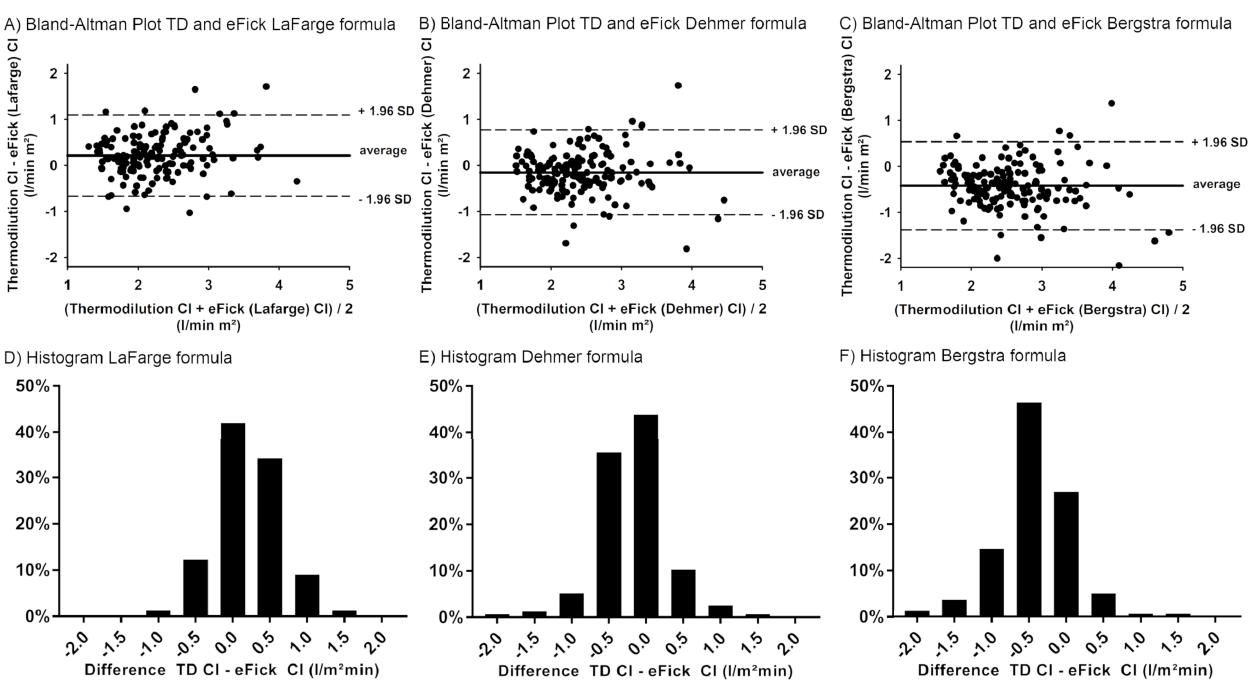
Fig 1. a-f. Bland-Altman Plots and histograms comparing measured and estimated CI by the formulas of LaFarge, Dehmer and Bergstra. a-c) Bland Altman Plots comparing measured and estimated CI by the formulas of LaFarge, Dehmer and Bergstra, respectively; d-e) Histograms comparing the absolute differences between measured and estimated CI by the formulas of LaFarge, Dehmer and Bergstra, respectively. Abbreviations: CI denominates cardiac index; eFick, estimated Fick method and SD, standard